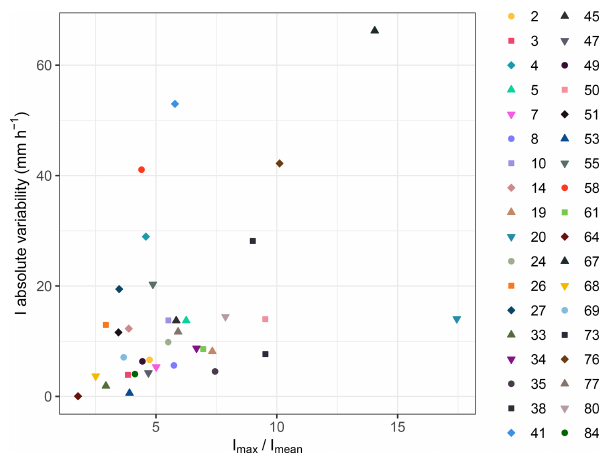
Figure 9. Positive correlation between the non-null absolute vari- ability of I and I max /I mean . I max is the maximum intensity, and I mean is the mean intensity of the main part of the hyetograph. The Spearman correlation coefficient is equal to 0 . 48 ( p = 0 .